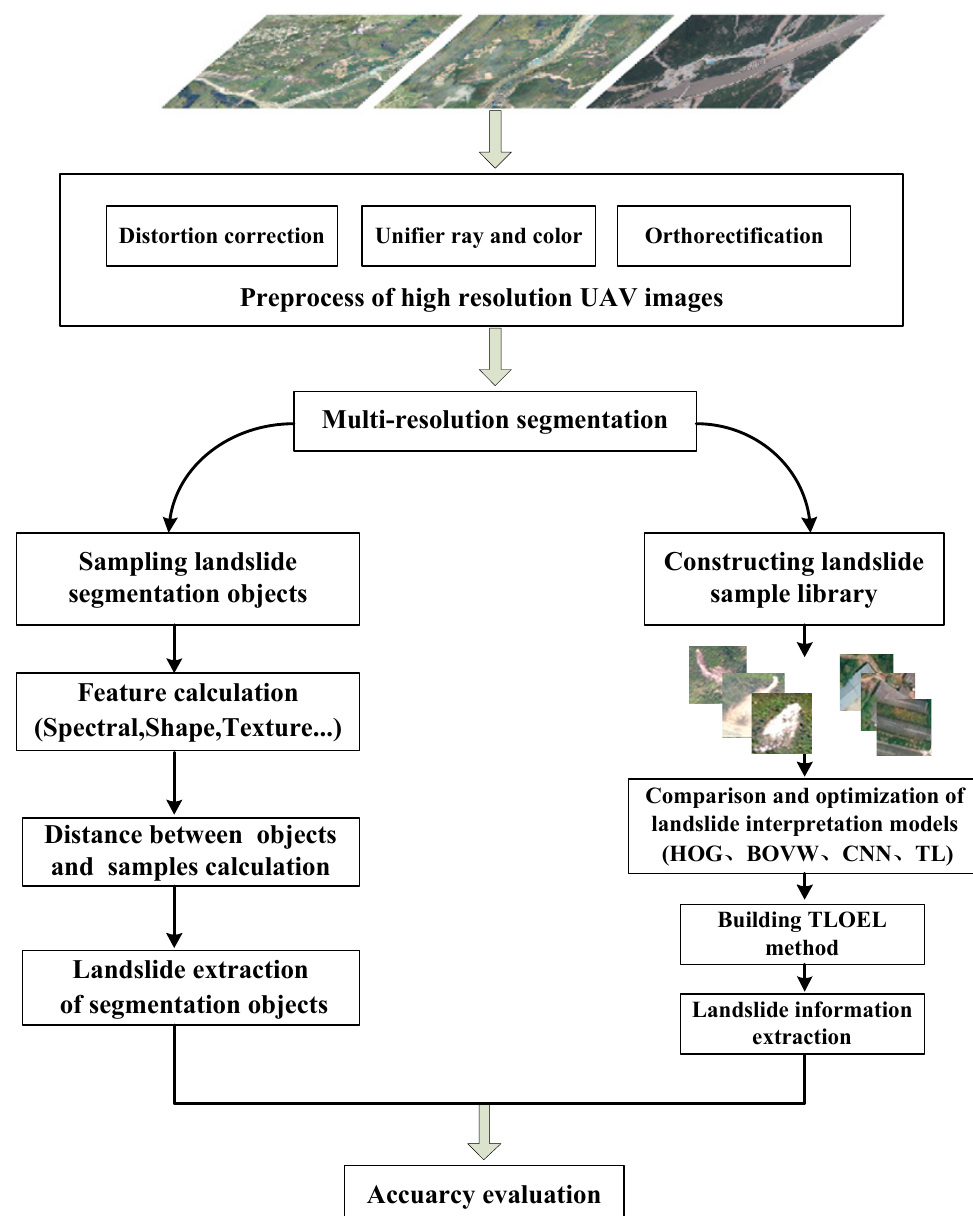
Figure 2. The workflow of landslides information extraction from high-resolution UAV imageries.